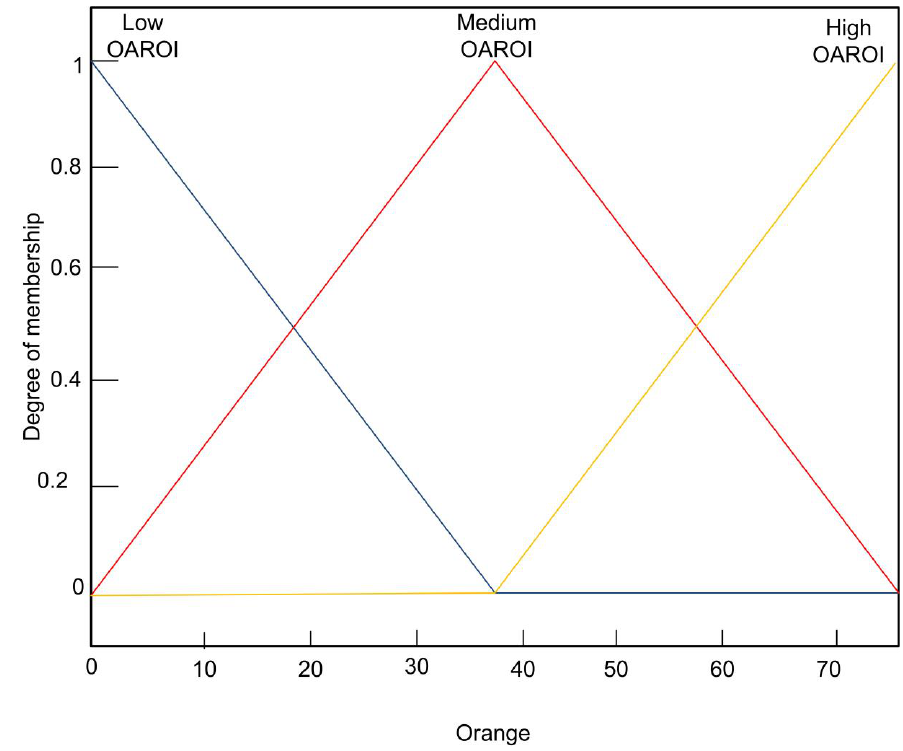
Figure 13 Figure 13. Membership functions of OAROI input.